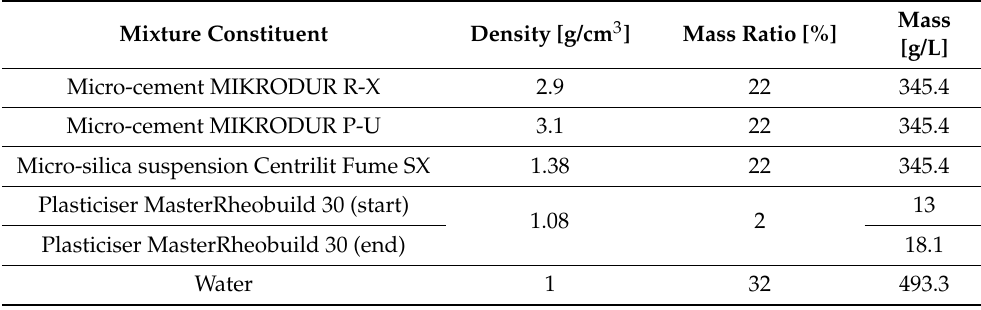
Table 2. Composition and mixing ratios of the 1 L mineral-based impregnation suspension. Mixture Constituent Density [g/cm 3 ] Mass Ratio [%]